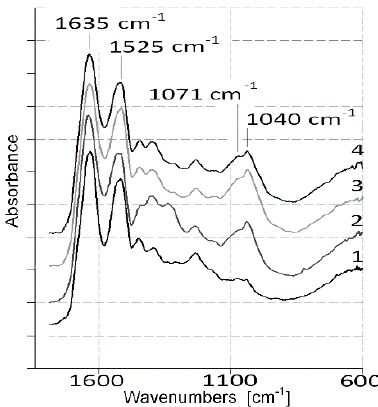
Figure 2. FTIR-ATR absorption spectra of fibers: contemporary alpaca fibers ( 1 ); archeological fabric ( 2 ); archaeological fabric after biofilm formation by P. aeruginosa KP842564 ( 3 ); archeological fabric after biofilm formation by P. aeruginosa KP842565 ( 4 ).